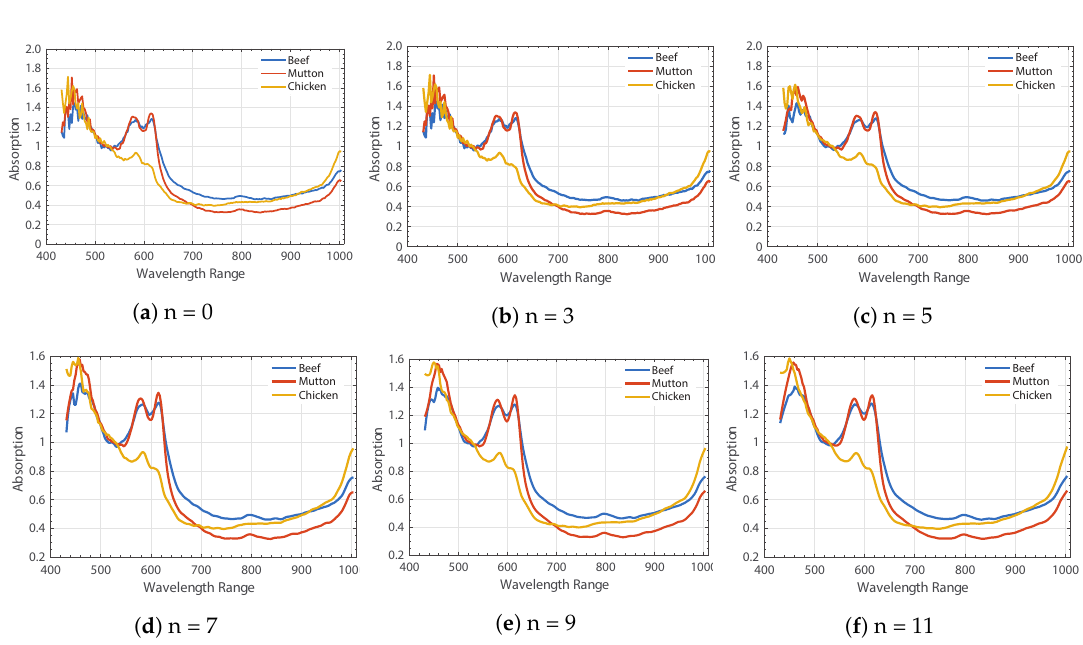
Figure 6. Savitzky–Golay spectral Pre-processing with several window sizes (n) for smooth Mb